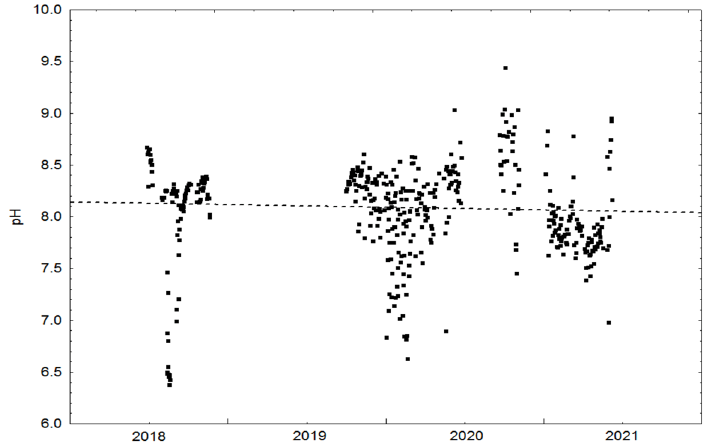
Figure 5. pH registrations in the 300,000 L reactor during the cultivation sessions. The dotted line indicates ca. pH in the cultivation medium (seawater and added inorganic nutrients without algae, i.e., reactor intake water).